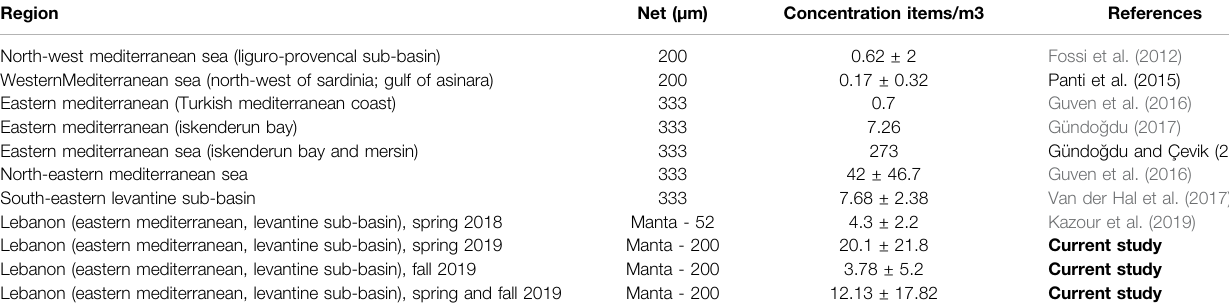
TABLE 4 | Literature data showing MP average density in items/m 3 in different regions of the Mediterranean Sea.